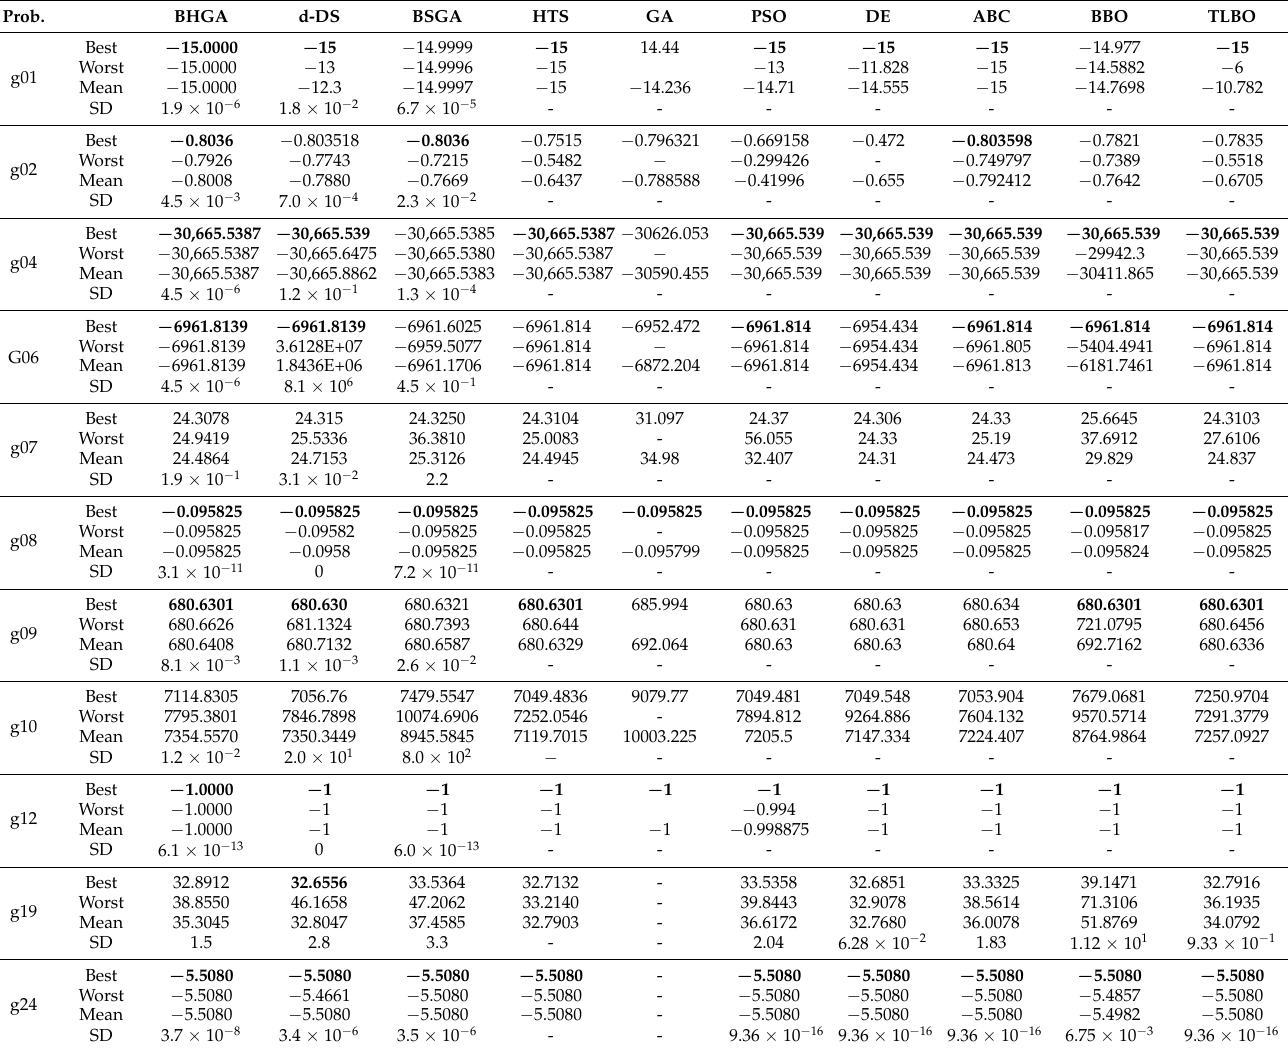
Table 6. Comparative results of benchmark functions obtained by different